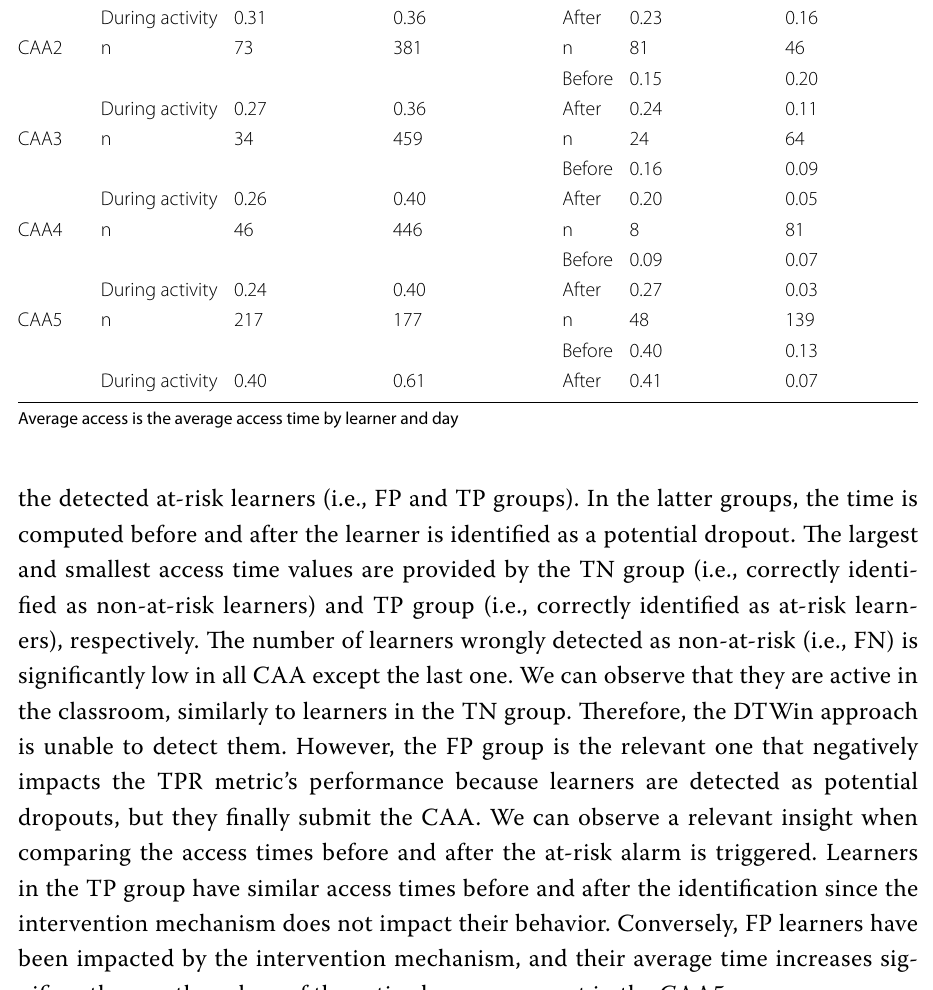
Average access is the average access time by learner and day